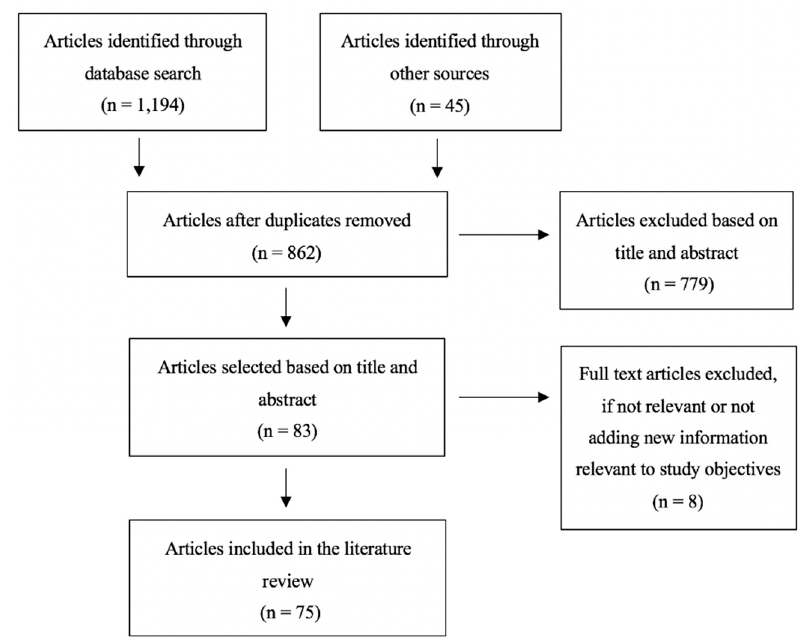
Figure 1. Preferred Reporting Items for Systematic Reviews and Meta-Analysis (PRISMA) flow diagram. Table 3. Table of search terms used.